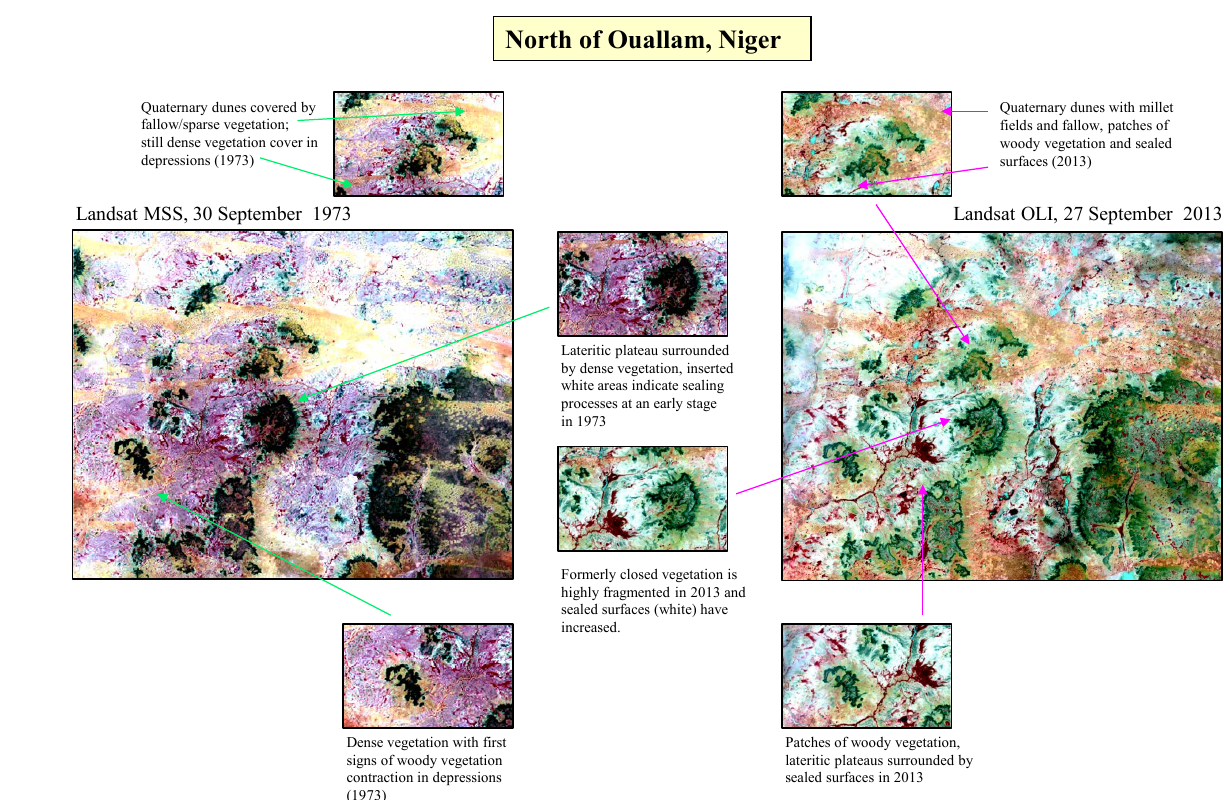
Figure 15. Comparison of two Landsat images from 1973 and 2013 showing how the ligneous vegetation pattern has formed out of an originally uniform vegetation cover within 40 years (size of subset is approx. 60km ×